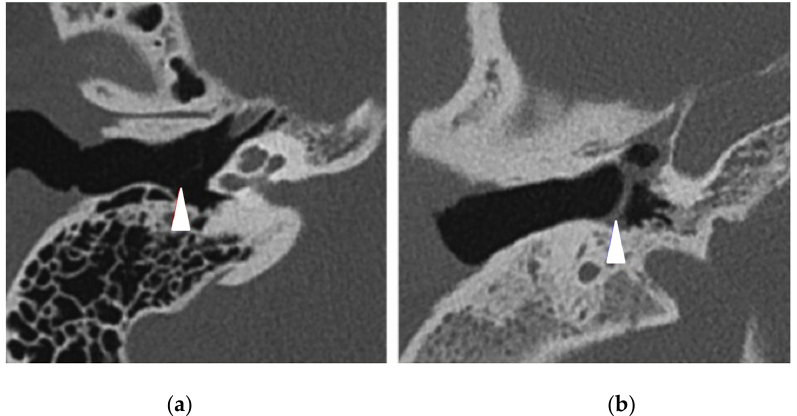
Figure 1. Right temporal bone CT scans in axial view showing (white arrowheads) ( a ) a normal thin tympanic membrane (control patient) and ( b ) a middle ear inflammation with a tympanic membrane thickening (PCD patient). Table 4. Comparison of temporal bones CT-scan anomalies between PCD and control